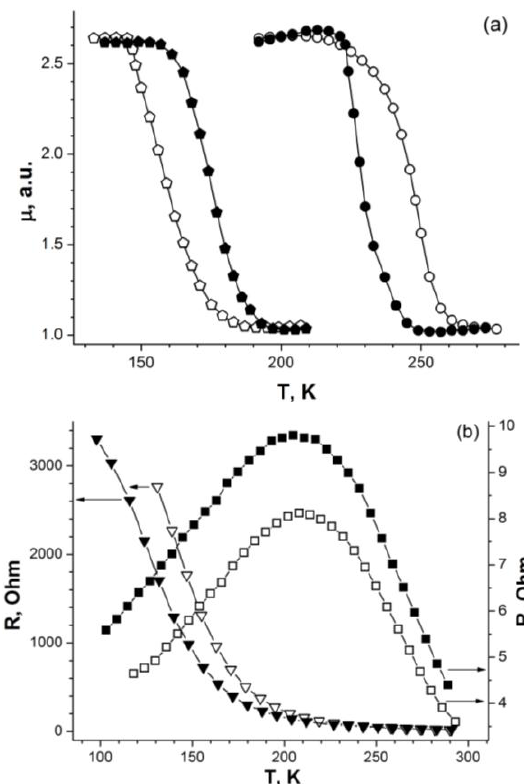
Fig. 2 . Temperature dependencies of magnetic permeability (a) and electrical resistance (b) of manganites in initial state (light symbols) and in the end of storage period (black symbols): (  ,  ) – x = 0.050; ( ,  ) – x = 0.150; (  ,  ) – х = 0.025; (  ,  ) – х = 0.100